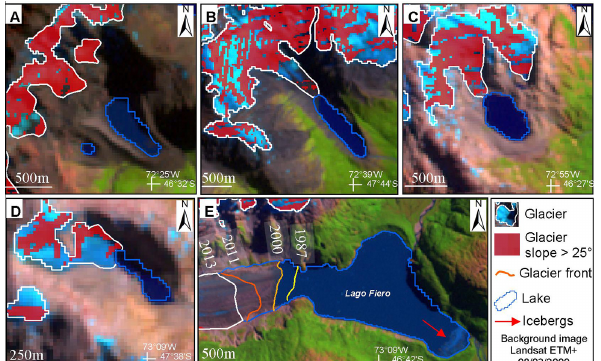
Figure 11. Examples of lakes classified with high or very high out- burst susceptibility. Steep glaciers, moraines and rock-slopes sur- round small and medium-sized lakes. Large growing lakes are in contact with retreating glaciers and have vegetated dams (panel E). Icebergs are common in proglacial lakes in contact with grounded glaciers.